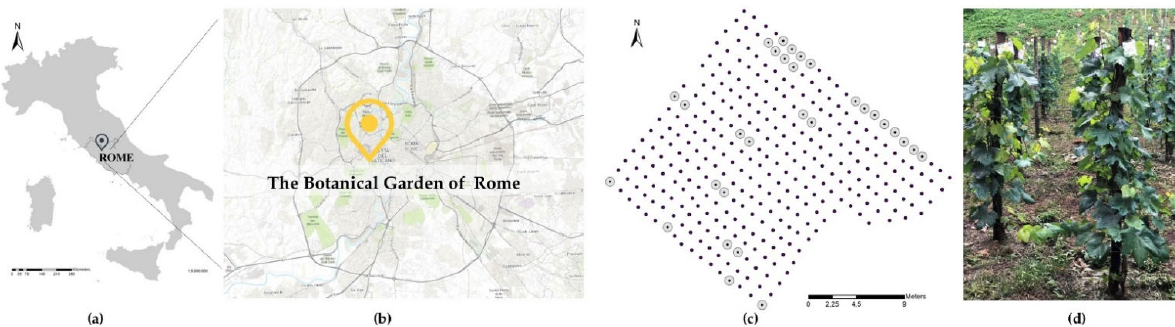
Figure 1. Geographical localization of the Botanical Garden in the center of Rome ( a , b ); map of the grapevine collection with the 15 selected genotypes (grey circles) ( c ); and vines trained to bush vine trellis systems ( d ).